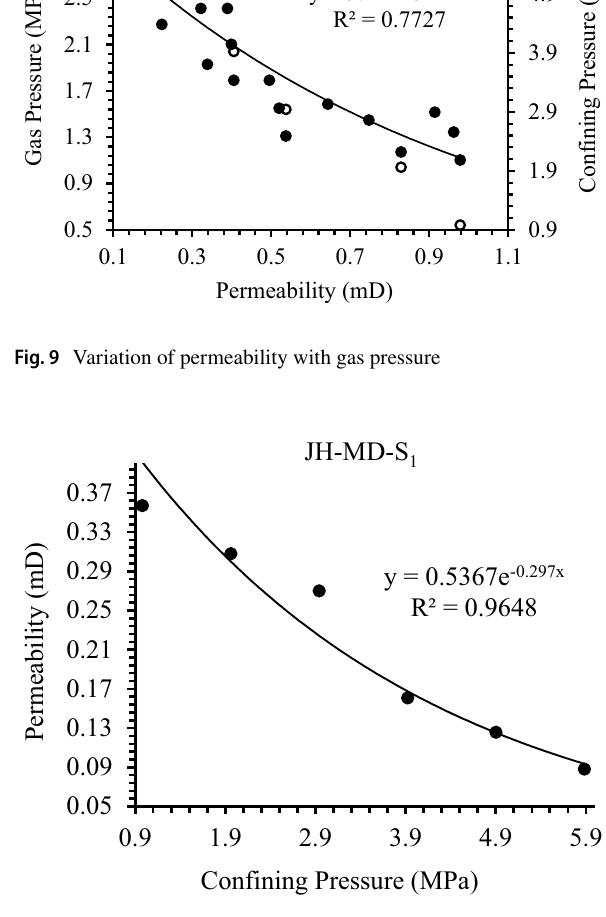
Fig. 10 Correlation of permeability with confining